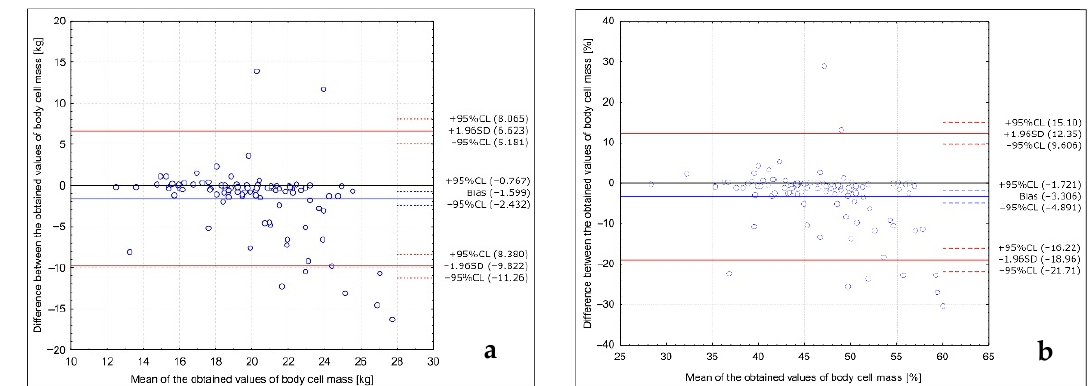
b a Figure 1. Analysis of the Bland–Altman plots comparing the body cell mass results in the studied group of Caucasian young normal body mass women measured in the follicular phase in various positions (with arms abducted at least 30 ◦ and legs abducted at approximately 45 ◦ ; with arms and legs separated to not touch the body) for the results in kg ( a ) and in the % ( b ). The analysis of the quartile distribution of extracellular water results in the studied group of Caucasian young normal body mass women measured in the follicular phase in various positions (with arms abducted at least 30 ◦ and legs abducted at approximately 45 ◦ ; with arms and legs separated to not touch the body) is presented in Table 4. It was stated that the results for two measurements were compatible (participants classified into the same quartile) for 69% and 53% of the studied group for the results observed in kg and the % of body water, respectively. It corresponded the weighted κ statistics of 0.644 and 0.456, respectively, being interpreted as a substantial and moderate agreement, respectively. It should be indicated that the results not differing (in kg) were associated with a substantial